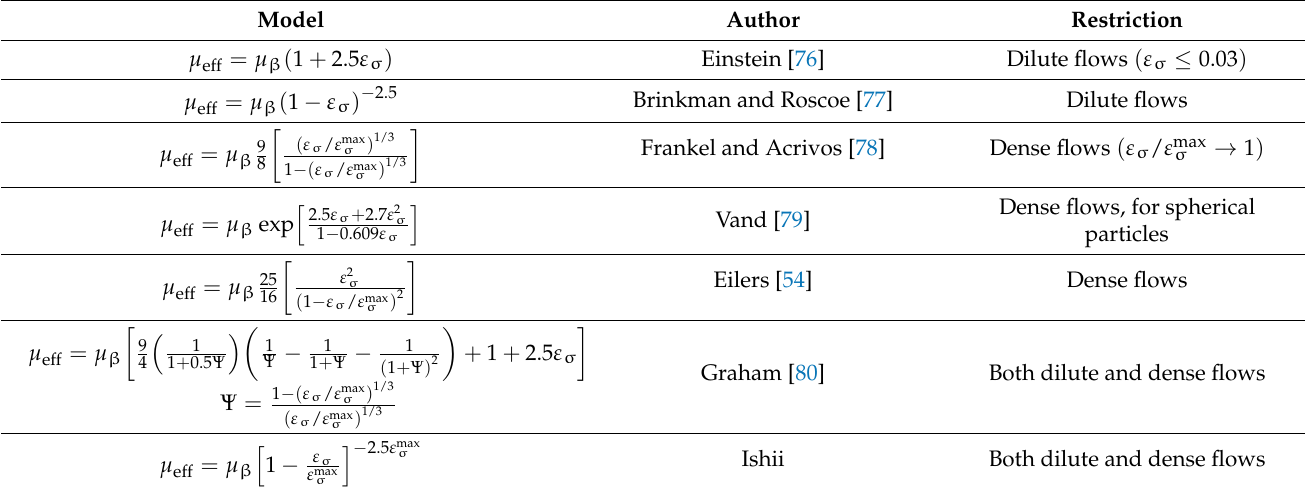
Table 2. Commonly reported effective viscosity